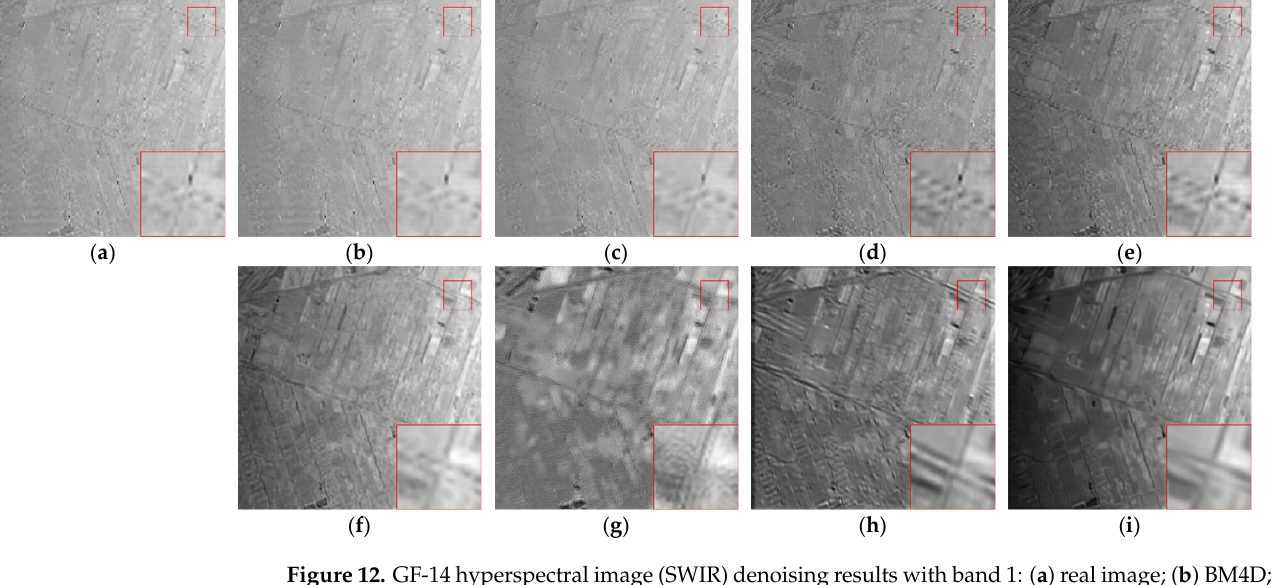
Figure 12. GF-14 hyperspectral image (SWIR) denoising results with band 1: ( a ) real image; ( b ) BM4D; ( c ) LRMR; ( d ) HyRes; ( e ) L1HyMixDe; ( f ) DHP-2D; ( g ) SIP; ( h ) SURE-CNN; and ( i )